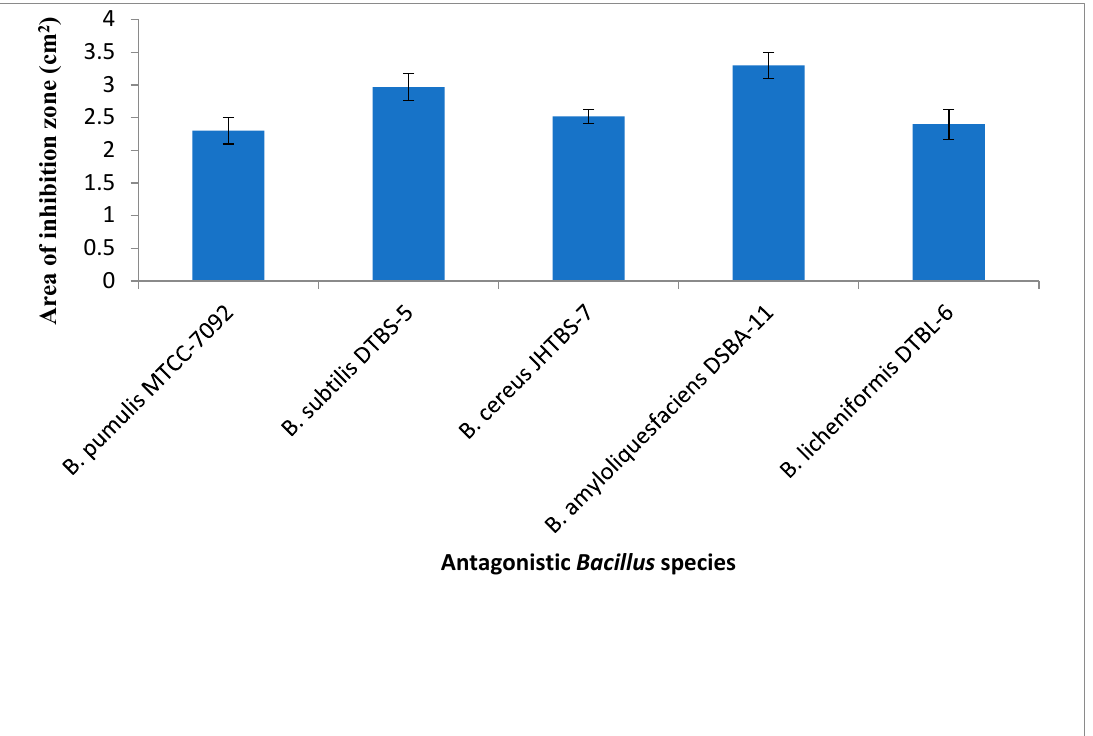
Figure 1. The antagonistic ability of Bacillus spp. against R. pseudosolanacearum under in vitro